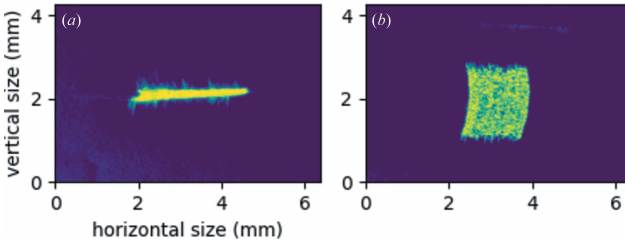
Figure 5 ( a ) Optical image of a diffuse light source reflected from the conical analyzer in horizontal von Ha´mos geometry (see text for details), the detector being in the focus. Note that the image does not represent real colors, only intensity. ( b ) The same image as for ( a ), but the detector is moved closer to the